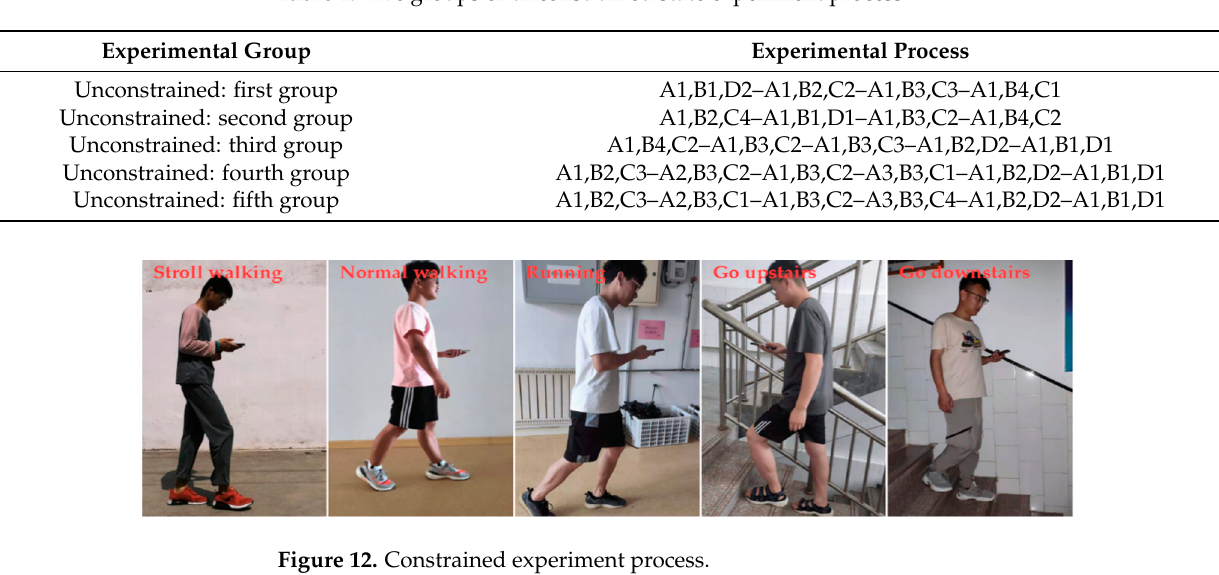
Table 4. Five groups of unconstrained state experiment process.